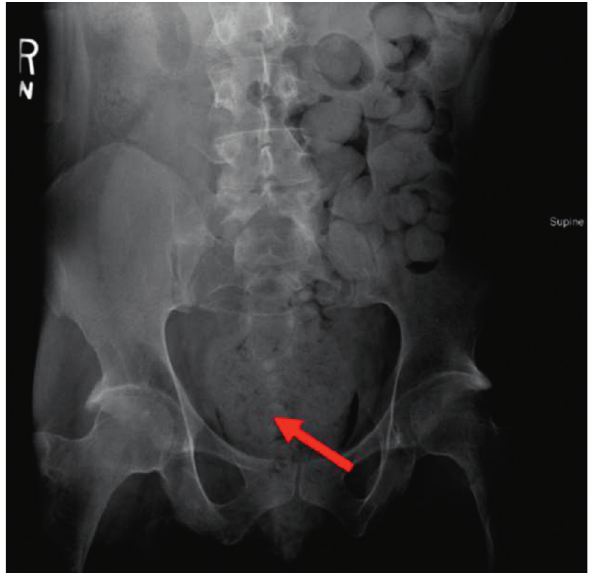
Figure 1: Abdominal X-ray radiography demonstrating fecaloma in a 34-year-old patient with intellectual and developmental dis- abilities and chronic constipation. The image shows a 10.2cm fecaloma (red arrow) located in the rectum, with the presence of a high colonic stool burden